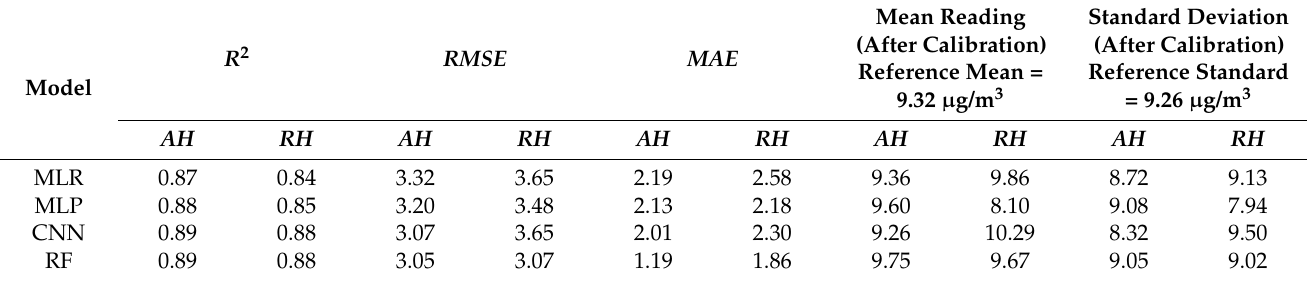
Table 2. Statistical performance measures analysis for PM 2.5